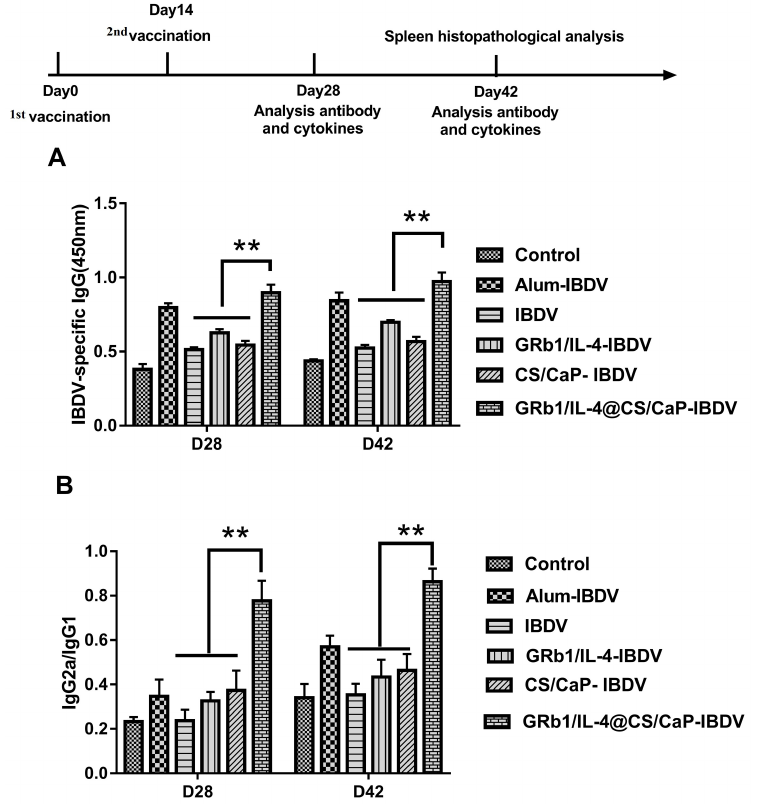
Figure 5. Chicken were subcutaneously vaccinated twice at a 2-week interval under varying vaccina- tion programs. The chicken sera were harvested 28 d following the final vaccination after sacrifice. ( A ) IBDV-specific IgG output; ( B ) The IgG2a-to-IgG1 ratio. Data represented are means ± SEMs (** p <